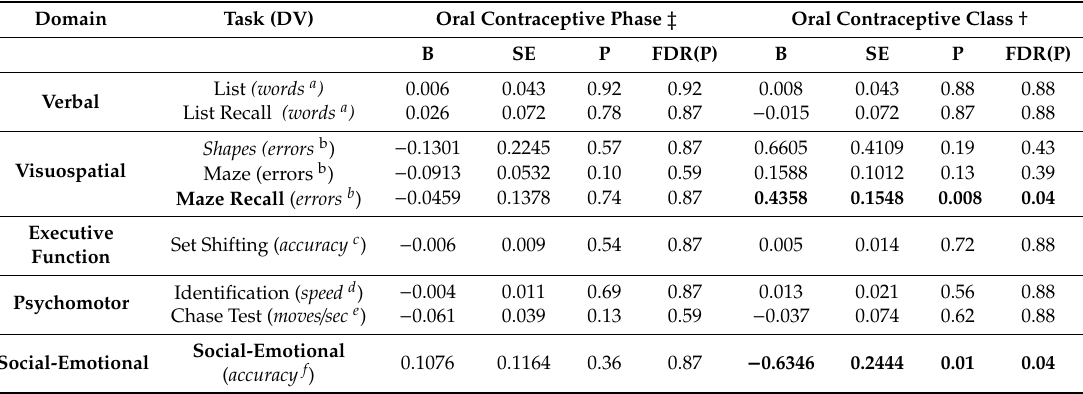
Table 5. Results of MIXED / GLIMMIX procedures models for each task